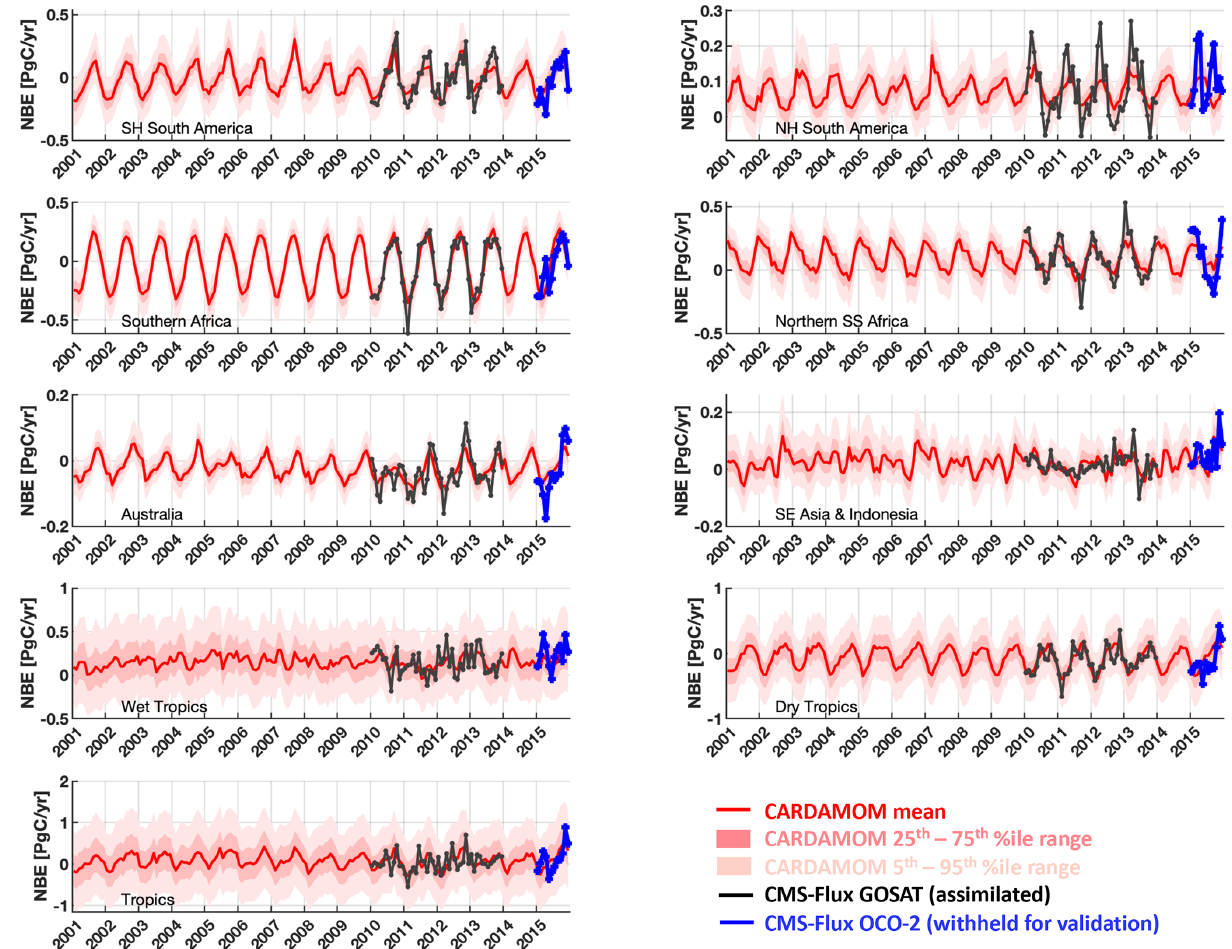
Figure 4. CARDAMOM monthly analyses of 2001–2015 median NBE (red line) and associated uncertainty intervals (25th–75th percentiles in dark pink and 5th–95th percentiles in light pink). The analyses were constrained by CMS-Flux GOSAT-derived top-down fluxes (Liu et al., 2018) for the 2010–2013 period; CMS-Flux OCO-2-derived 2015 NBE fluxes were withheld for validation. The geographical definitions for each region are shown in Fig. A1 in the Appendix. Table 3. 2001–2015 regional (cid:49) NBE IAV and corresponding contributions of concurrent effects ( (cid:49) NBE CON ) and lagged effects ( (cid:49) NBE LAG ); IAV values are represented here as standard deviations of annual 2001–2015 NBE values; bracketed values represent Pearson’s correlation coefficients between total NBE and concurrent and lagged effect IAV. The regional masks are depicted in Fig. A1. (cid:49) NBE IAV (cid:49) NBE CON IAV (cid:49) NBE LAG